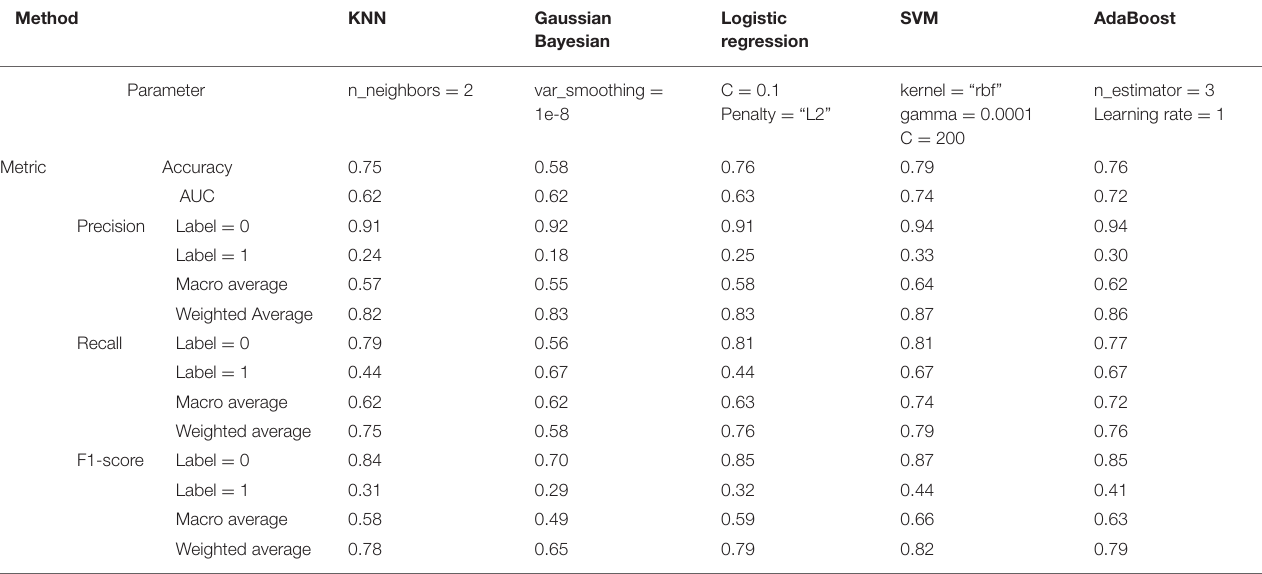
TABLE 4 | Classification performance of other five popular machine learning models.